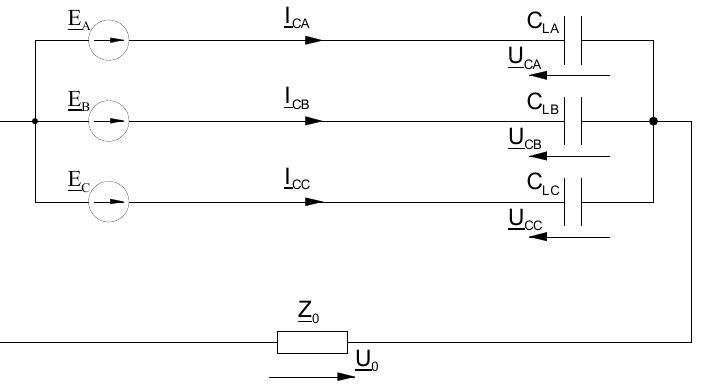
Figure 4. Equivalent diagram of MV power network without consideration of line loading. E A , E B ,